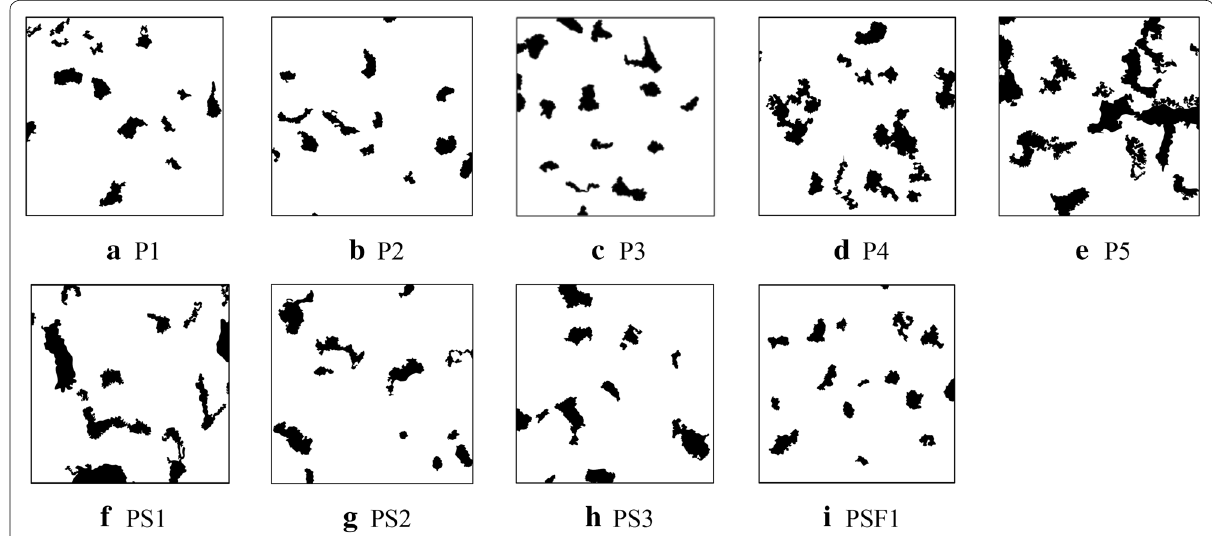
Fig. 5 Representative planar images of pervious concrete specimens with different mix proportions of pervious